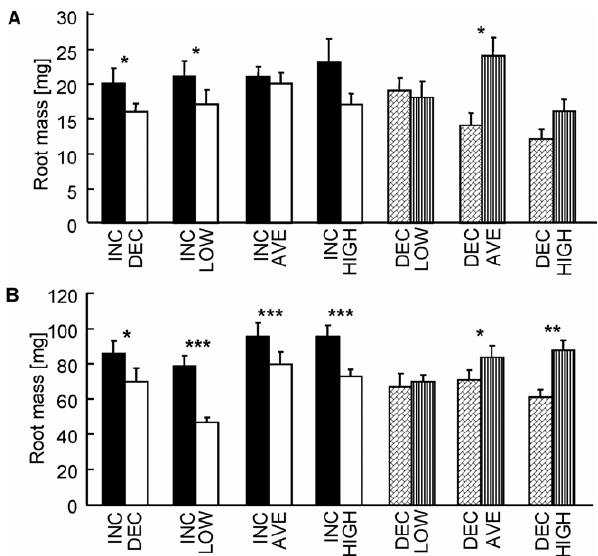
Figure 3. Patch choice in the increasing and decreasing treatments. Biomass of individual roots of split-root plants at the interim (a) and final (b) harvests of treatments that included dynamic nutrient regimes. Treatments including the INC regime are depicted by black and white bars, and treatments including the DEC regime are depicted by striped and checkered bars. Pair-wise comparisons were done using Wilcoxon Signed-rank Test; * , 0.05, ** , 0.01, *** , 0.001. Values are means 6 1 S.E.